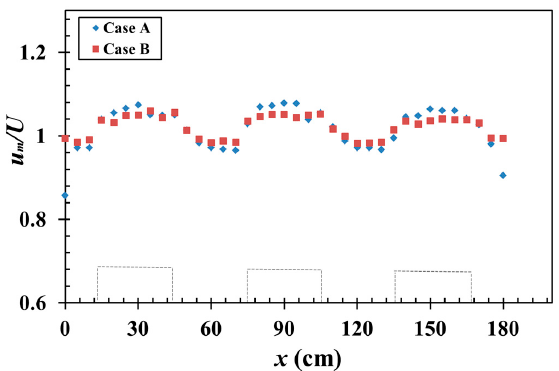
Figure 7. Fluctuations of depth-averaged mean velocity along the length for both Case A and Case B. The dashed boxes denote the vegetation patches.